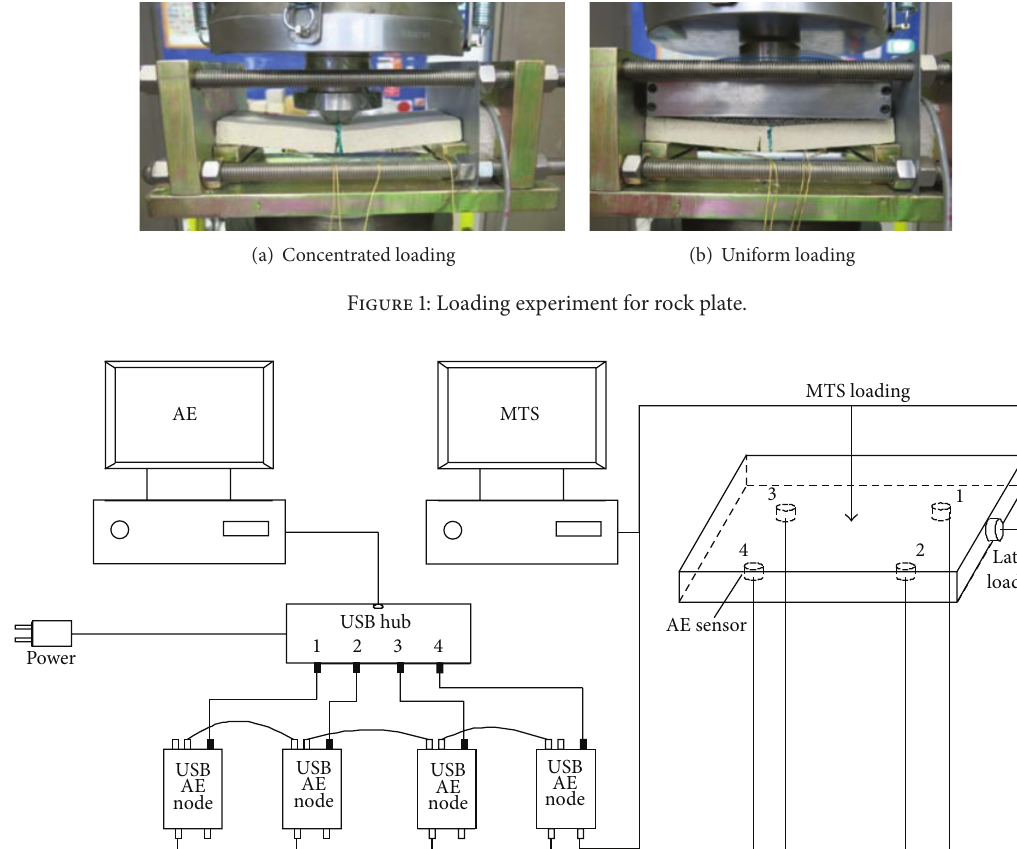
Figure 2: MTS connection with AE monitoring system diagram.